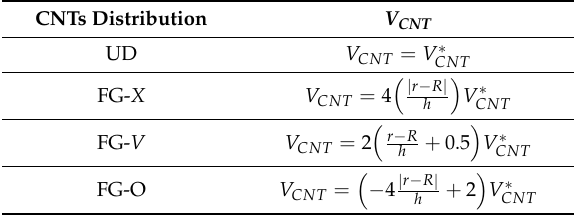
Table 1. Volume fraction of CNTs as a function of thickness coordinate for various cases of CNTs distribution